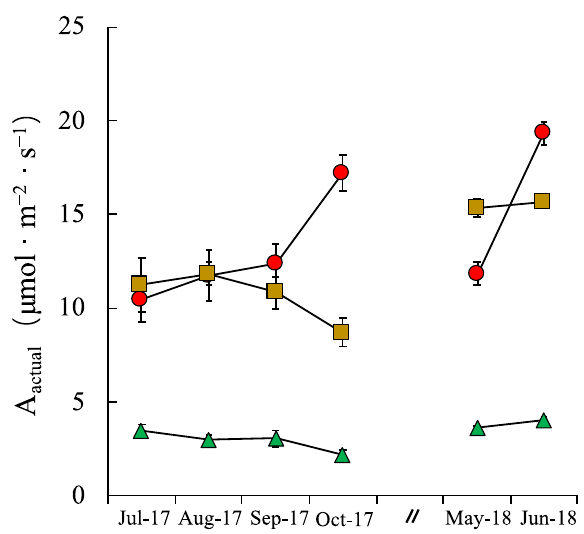
Figure 2. Monthly changes of estimate actual photosynthetic rates (A actural ) under actual ambient maximum photosynthetic photon flux density (max PPFD: µ mol · m − 2 · s − 1 ) of M. condensatu s grown in BL (circle), in SLG (square) and in SLUC (triangle). Vertical bars represent the mean ± SE (n = 8).